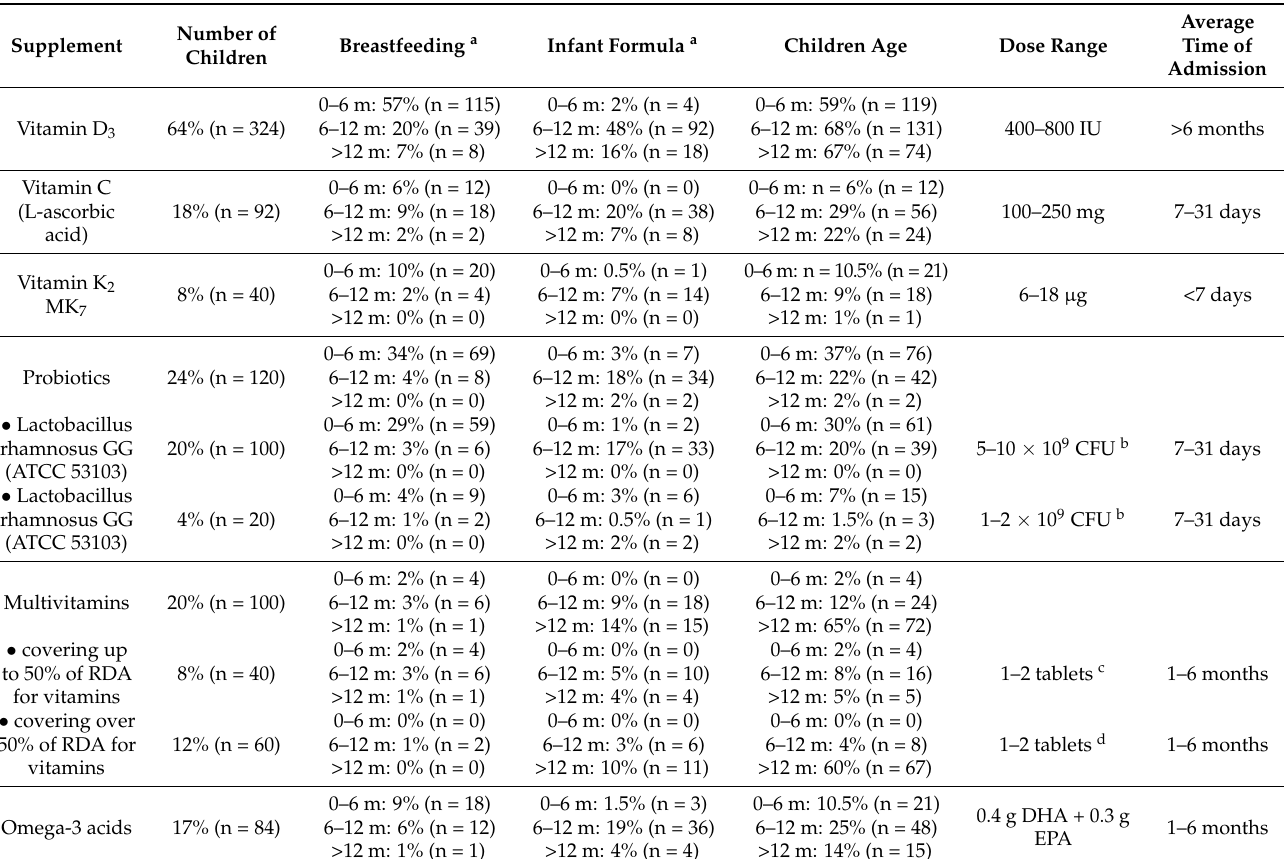
Table 2. Data concerning dietary supplement